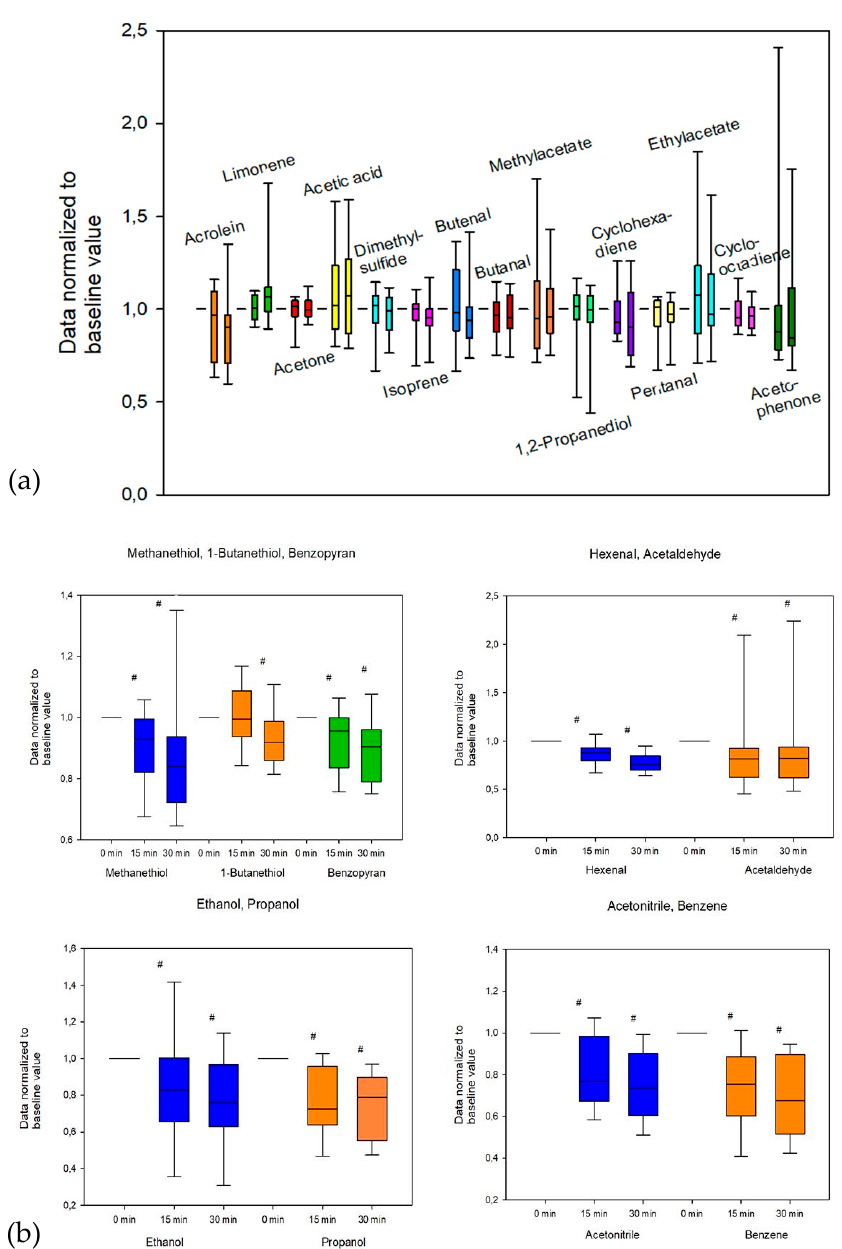
Figure 1. Normalized changes of VOCs. ( a ) The figure illustrates the distribution of data during the measurement time points (0 min, 15 min, and 30 min). Data were normalized to baseline values to show relative changes. ( b ) The figure illustrates the VOCs methanethiol, 1-butanethiol, benzopyran, ethanol, propanol, acetonitrile, benzene, hexenal, and acetylaldehyde, which were found to have significant changes during the observation period. Data were normalized to baseline values to show relative changes; hashes (#) indicate statistically significant changes.